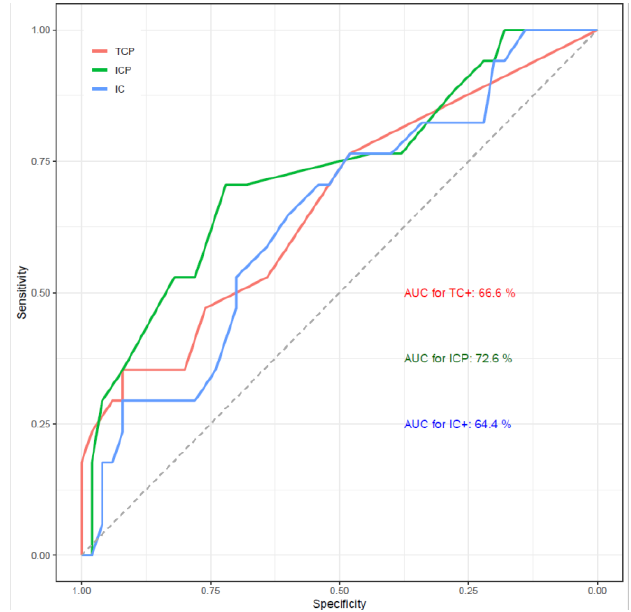
Figure 2. Area under the curve for best overall response for TC+ (red), ICP (green) and IC+ (blue). Table 1. Associations between OTRR and the three components and the